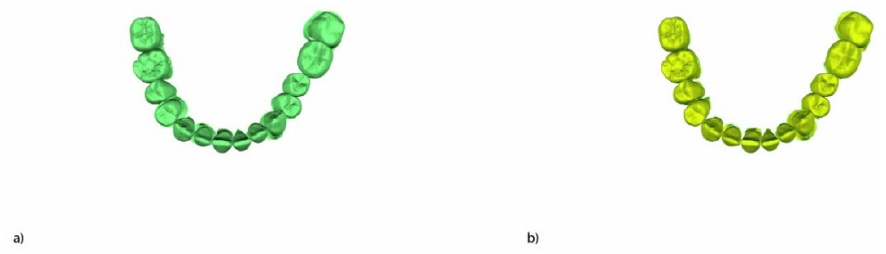
Figure 2. ( a ) Occlusal view of the individually segmented teeth of the preoperative and ( b ) postoperative interproximal enamel reduction STL digital files.